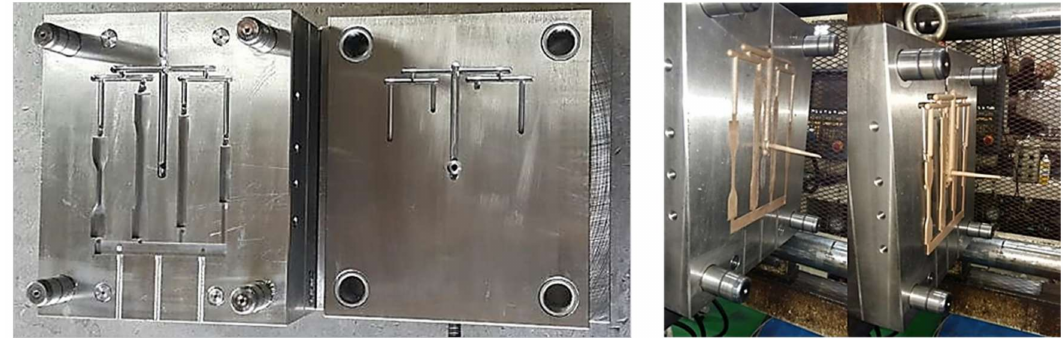
Figure 5. The injection molding American Society for Testing and Materials (ASTM) standard test mold used in this study.